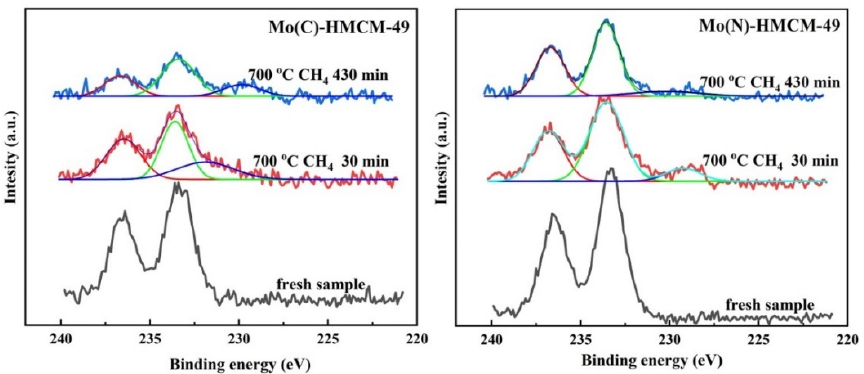
Figure 8. Mo 3d region XPS spectra of the C-Mo-HMCM-49 and N-Mo-HMCM-49 catalysts before and after reaction under CH 4 flow at 700 °C for 30 and 430 min.